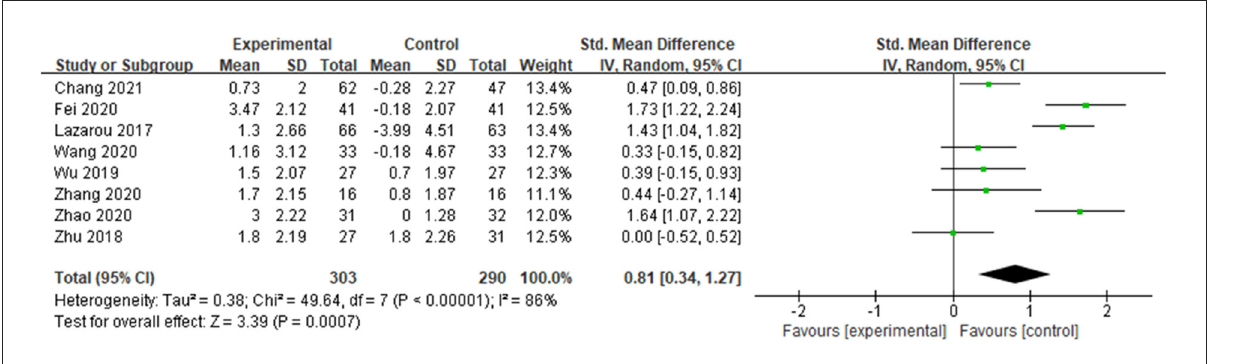
FIGURE5 Effects of dance activities on global cognition